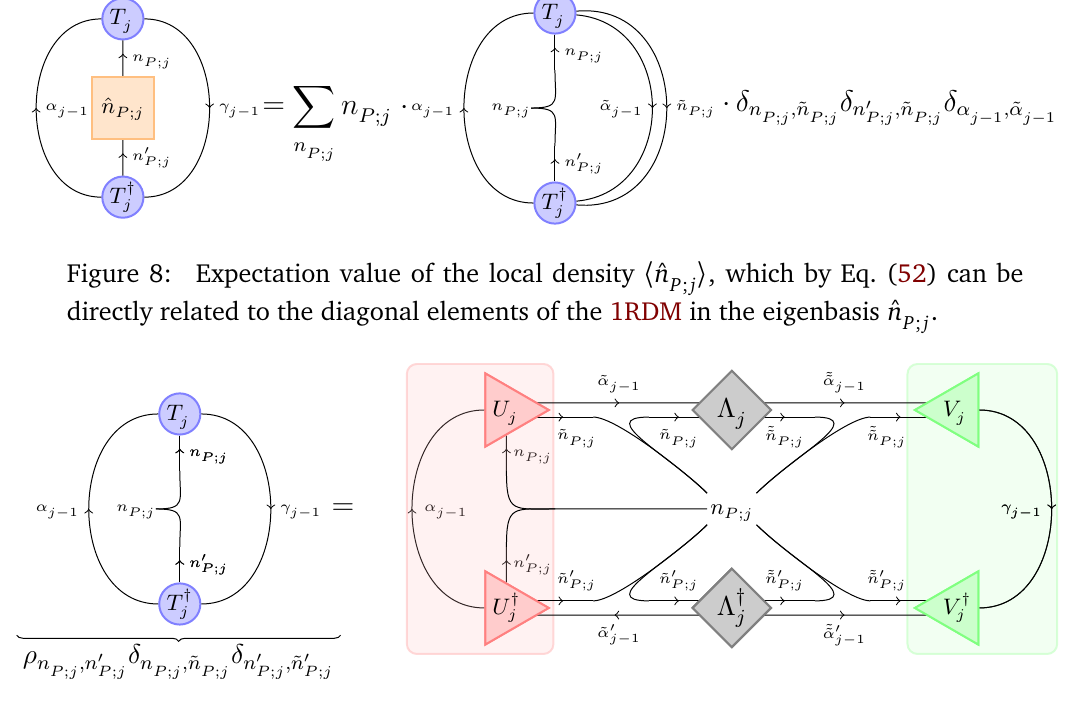
Figure 9: For a given n , the diagonal entry of the 1RDM is given by the singular P ; j values of the decomposed physical site. Note that we make extensive use of the tensor notation, in particular implicit deltas, which was introduced in [ 58 ]